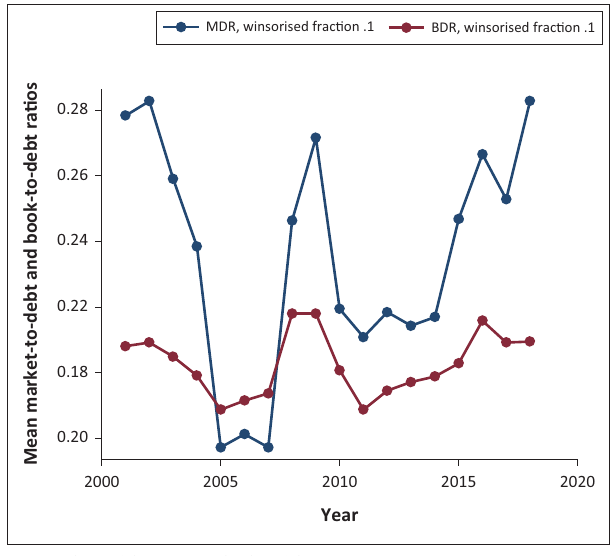
FIG URE 1: Full sample’s mean market-to-debt ratios